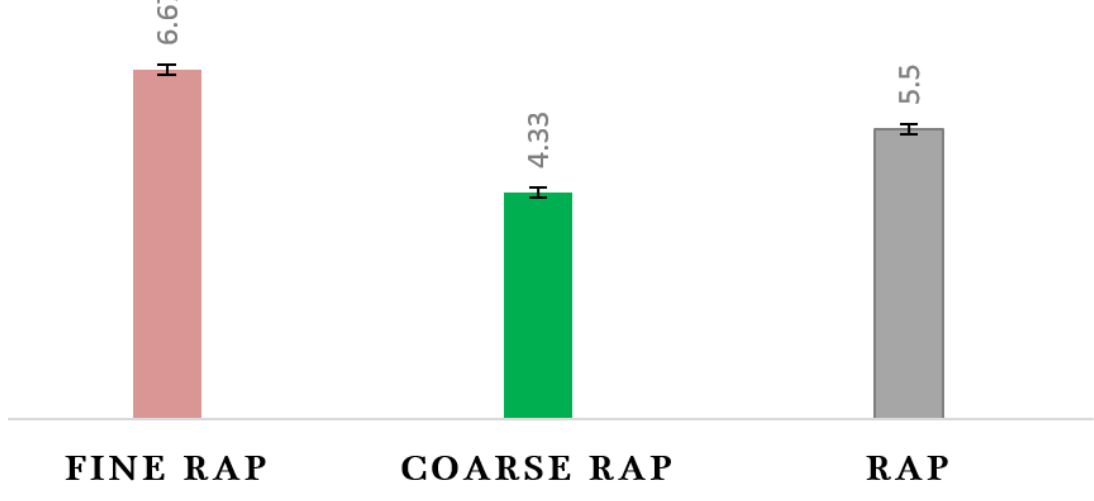
Figure 1. Bitumen content of fine reclaimed asphalt pavement (FR), coarse reclaimed asphalt pavement (CR), and reclaimed asphalt pavement (RAP) from the ignition test.